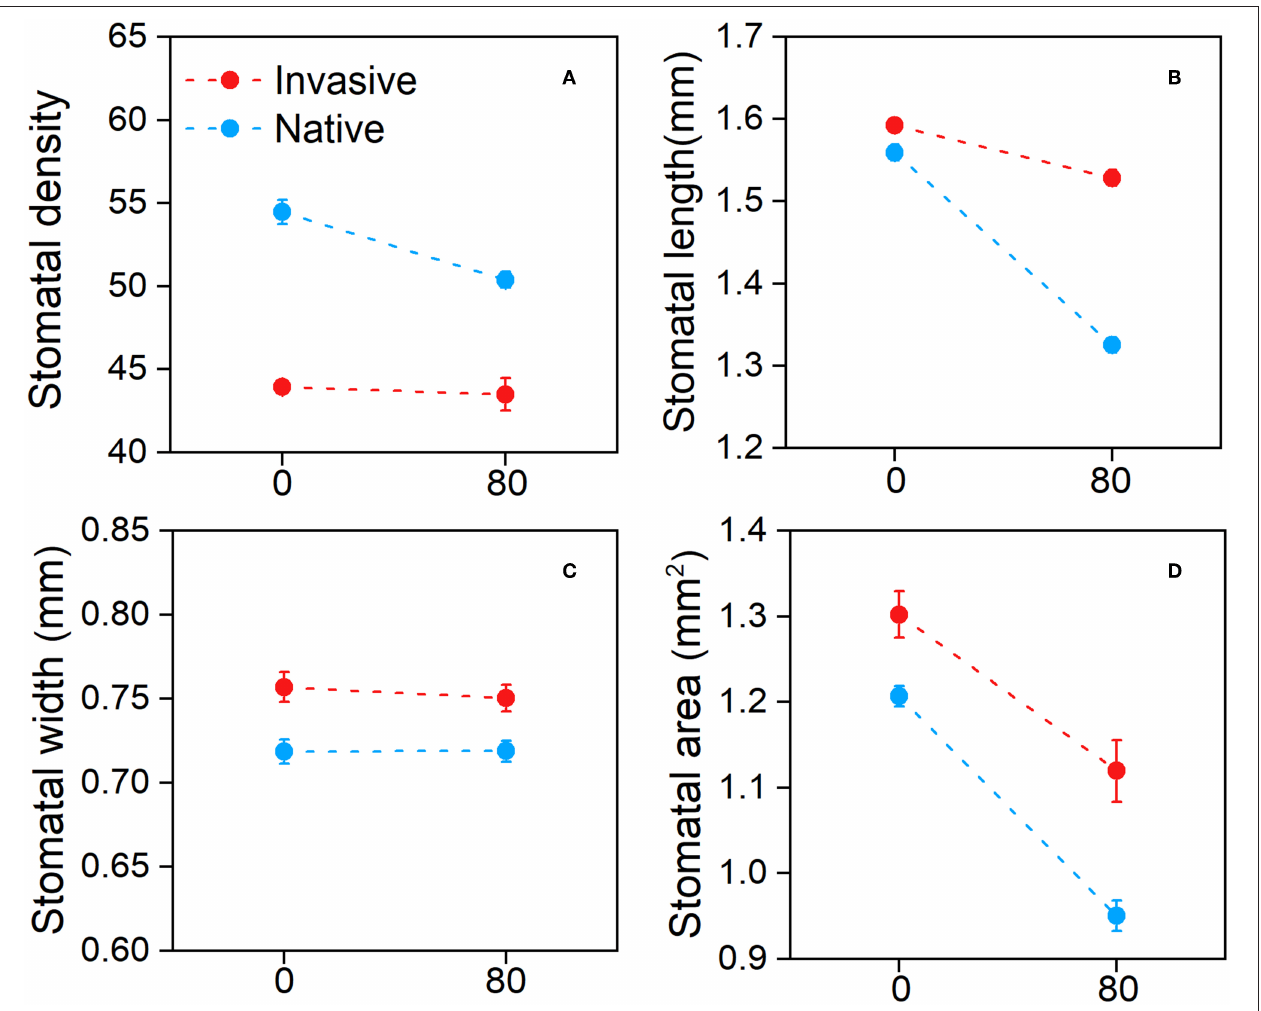
FIGURE 3 | Stomatal density (A) , stomatal length (B) , stomatal width (C) , and stomatal area (D) of the invasive and native plants in response to cadmium (Cd). Values are means ± standard error